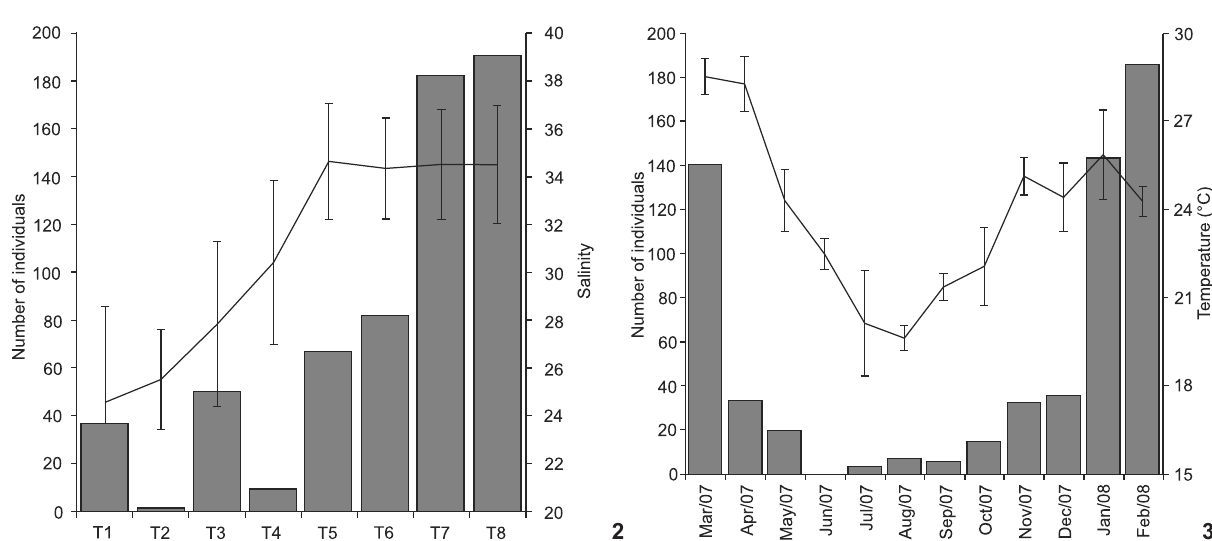
Figures 2-3. (2) Number of individuals (bars) and the mean salinity (lines) of each transect collected through the year. (3) Monthly distribution of Callinectes ornatus (bars), with the mean water temperature (line) through the months.